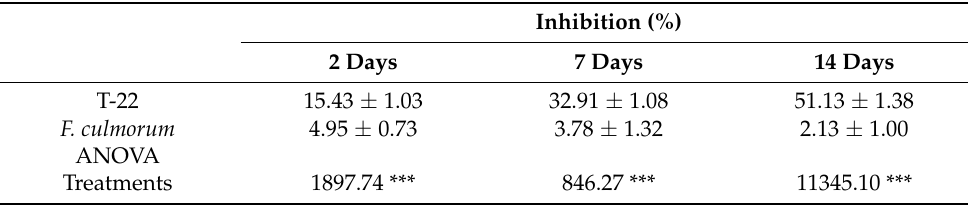
Table 2. In vitro antagonistic activity of Trichoderma harzianum T-22 against Fusarium culmorum